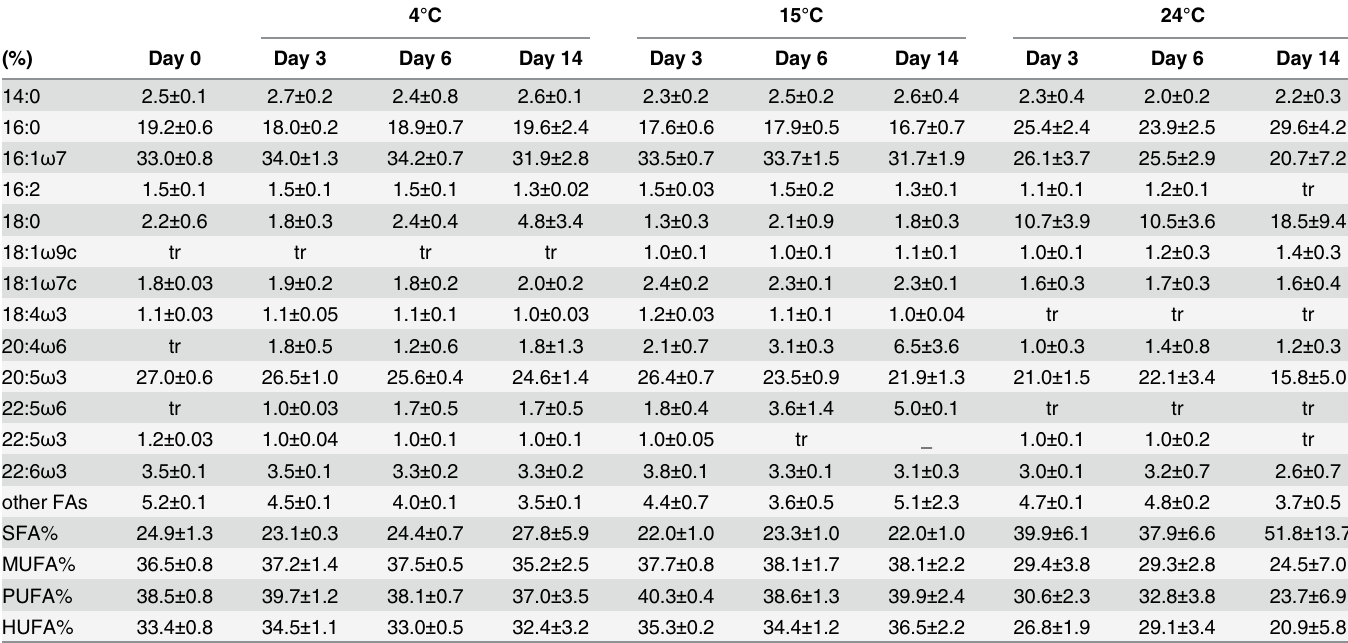
Table 2. Storage FA composition (% ± SD) of the copepod P . littoralis prior (day 0) and after 3, 6 and 14 days of food deprivation at different temper- atures (4, 15 and 24°C); tr, traces ( < 1%); other FAs, sum of all FAs < 1% in all